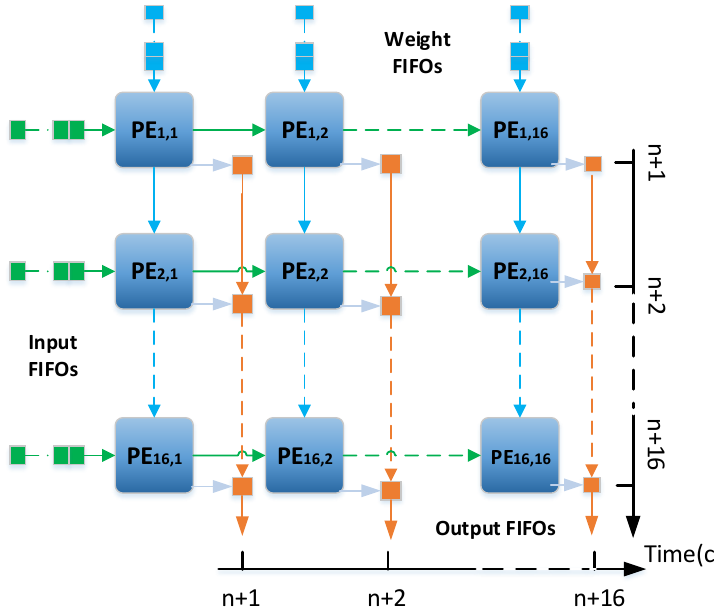
Figure 5. The structure of the systolic